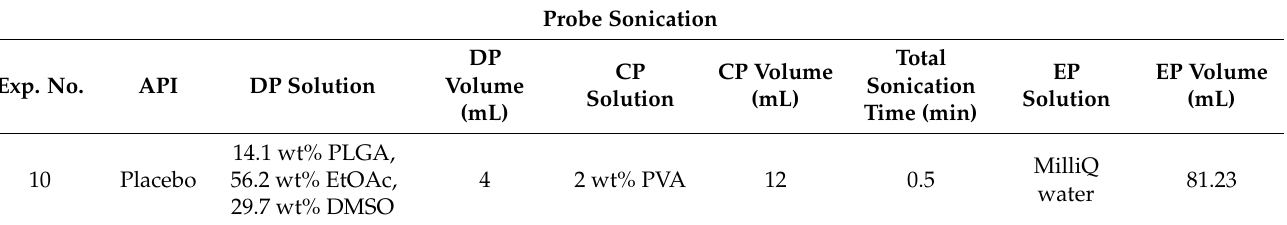
Table 4. Process parameters evaluated for the classic probe sonication method scale-up. Probe